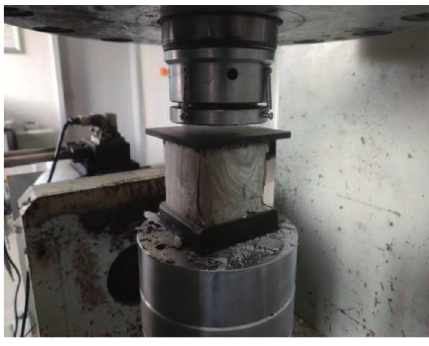
Figure 5: Compressive strength